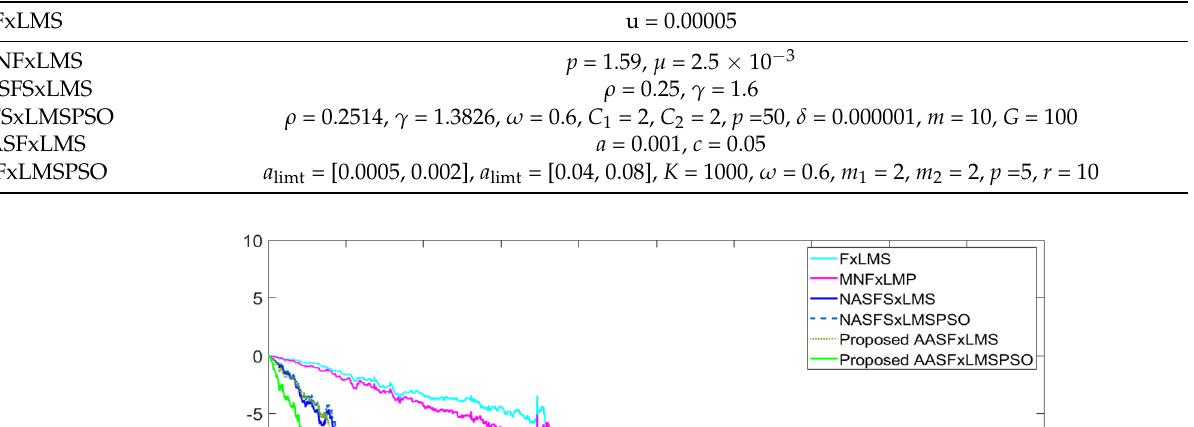
Table 1. The key parameters of each algorithm in the MATLAB simulation of Example 1.